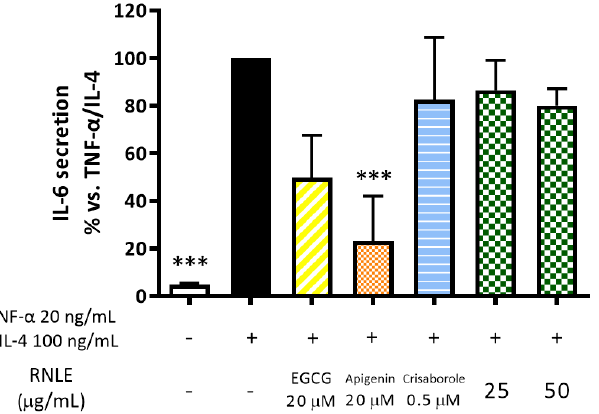
Figure 9. Effect of RNLE treatment (25–50 µ g/mL) on IL-6 secretion in differentiated HaCaT cells stimulated with a combination of IL-4 and TNF- α (100 ng/mL + 20 ng/mL, 24 h); the absolute amount of IL-6 in the stimulated condition was 612.59 ± 59.55 pg/mL. ( − )-Epigallocatechin 3-gallate (EGCG) 20 µ M, apigenin 20 µ M, and crisaborole 0.5 µ M were used as the reference compounds; *** p < 0.001 vs.